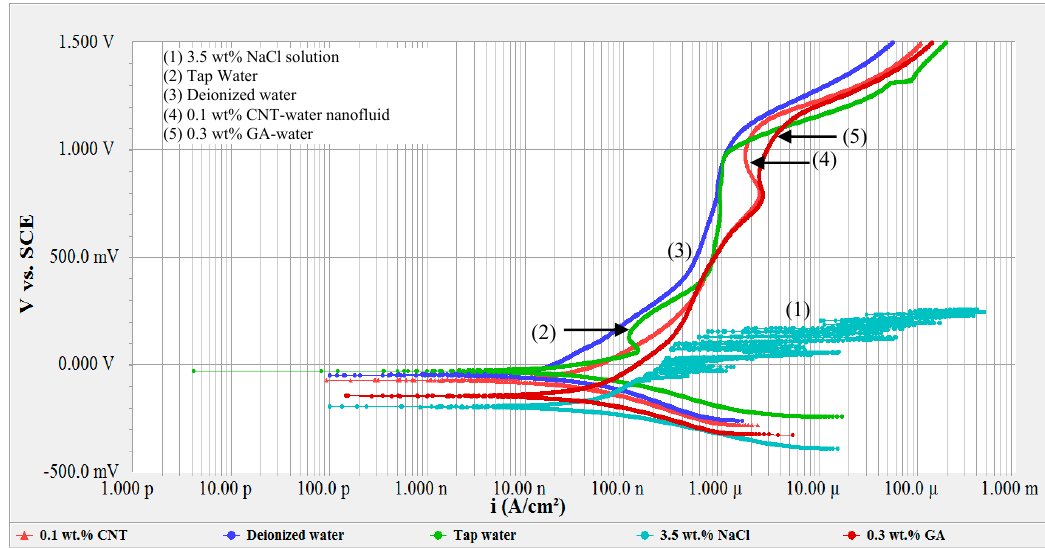
Figure 3. Potentiodynamic scans of 316L stainless steel in different solutions.